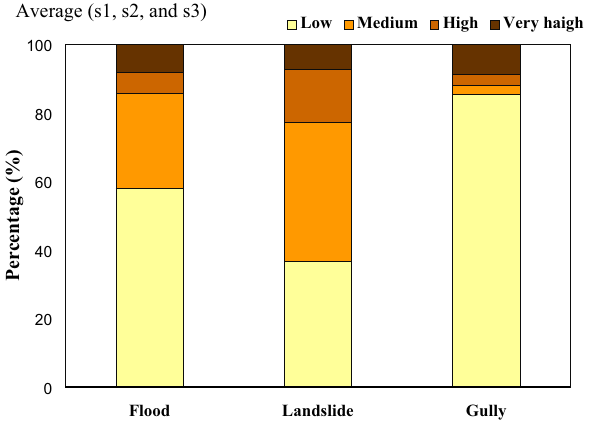
Figure 5. Relative distributions of the average of four susceptibility classes for the flood, landslides, and gully erosion susceptibility maps.